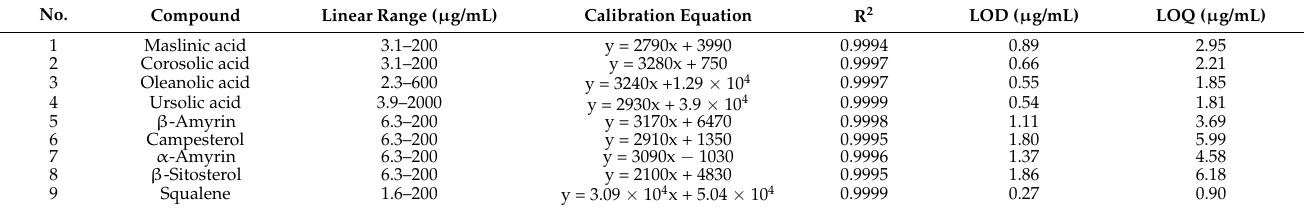
Table 1. Parameters of the limits of linearity, detection, and quantitation of the identified compounds.